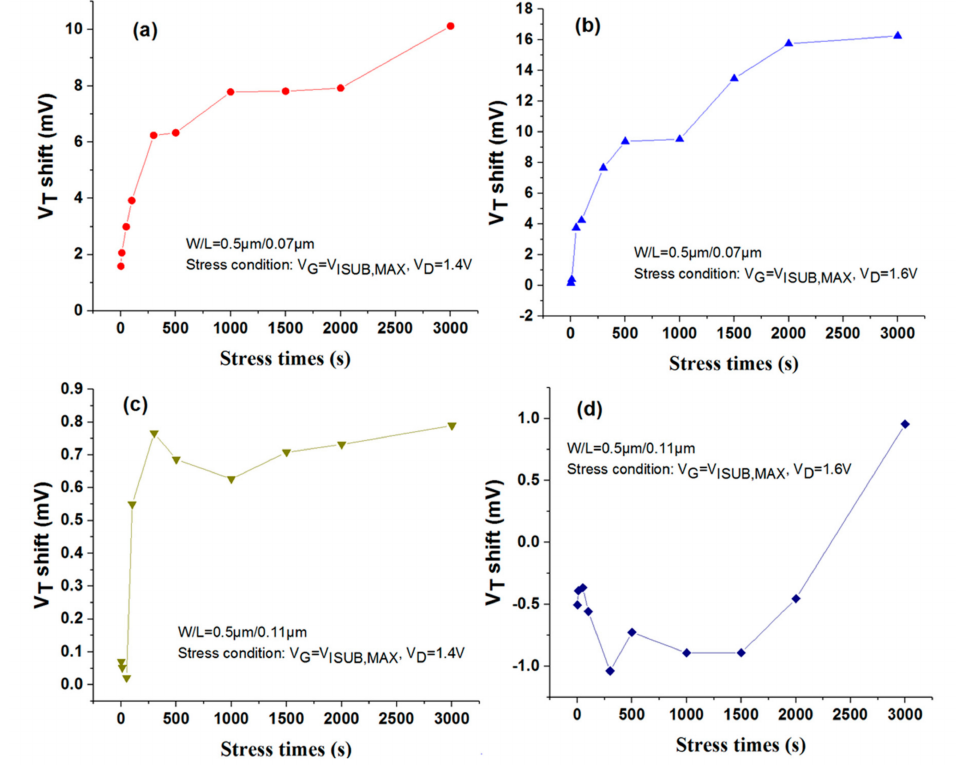
Figure 8. In DAHC test mode, the V T shift at: ( a ) W / L = 0.5 / 0.07 µ m / µ m, stressed at V GS at I SUB _ max plus V DS = 1.4 V, ( b ) W / L = 0.5 / 0.07 µ m / µ m, stressed at V GS at I SUB _ max and V DS = 1.6 V, ( c ) W / L = 0.5 / 0.11 µ m / µ m, stressed at V GS at I SUB _ MAX and V DS = 1.4 V, and ( d ) W / L = 0.5 / 0.11 µ m / µ m, stressed